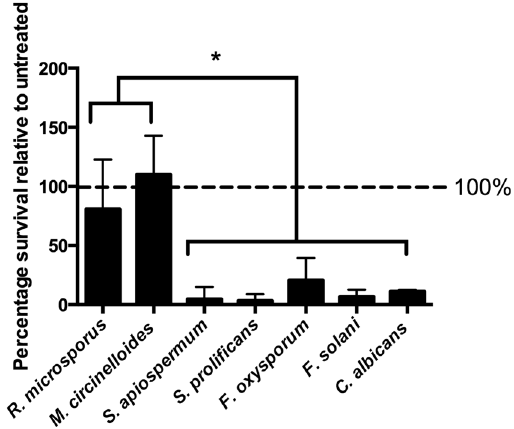
Figure 4. 60 min (216J/cm 2 ) blue light treatment of fungal spores in cold room conditions shows similar growth inhibition effects. Spores were inoculated in PBS and treated with blue light before plating for growth and CFU enumeration. Error bars represent standard deviation (n = 3, with three experimental replicates). One-way ANOVA followed by Tukey’s multiple comparisons test shows significant difference (p < 0.05 for all comparisons) in blue light treatment survival between R . microsporus and M . circinelloides and other species